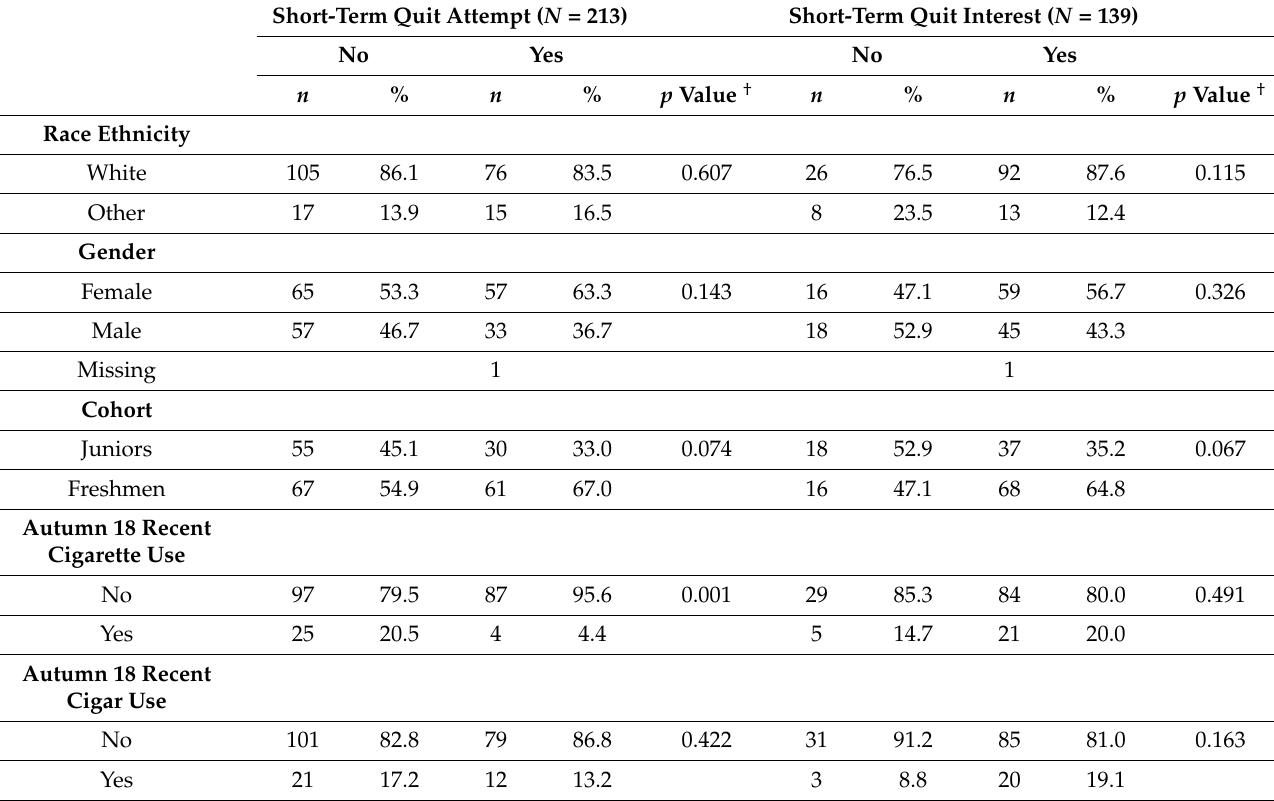
Table 1. Descriptive characteristics of current JUUL users by short-term quit